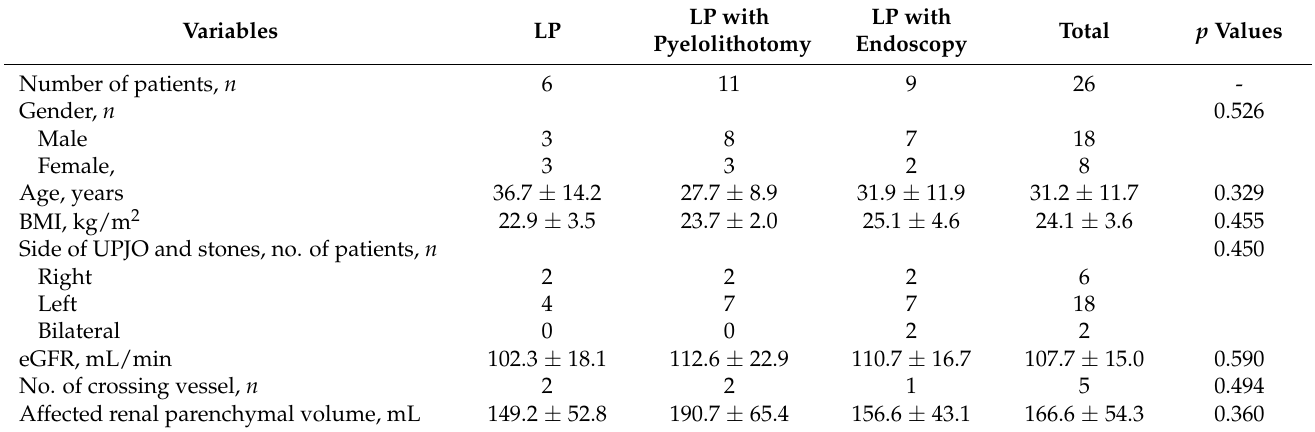
Table 1. Demographics, clinical, and stone assessment data of the